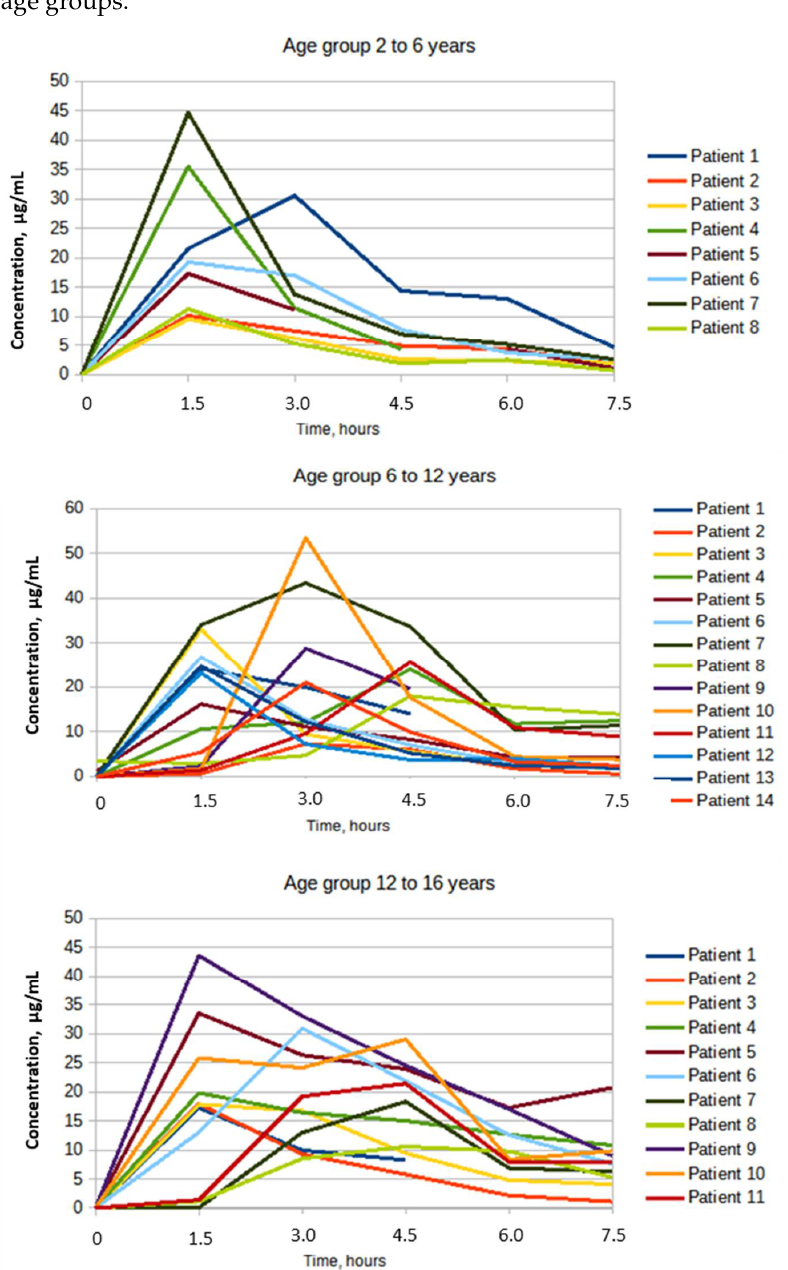
Figure 1. The dynamics of the CPF plasma concentration in different age groups measured within 7.5 h after a single dose.